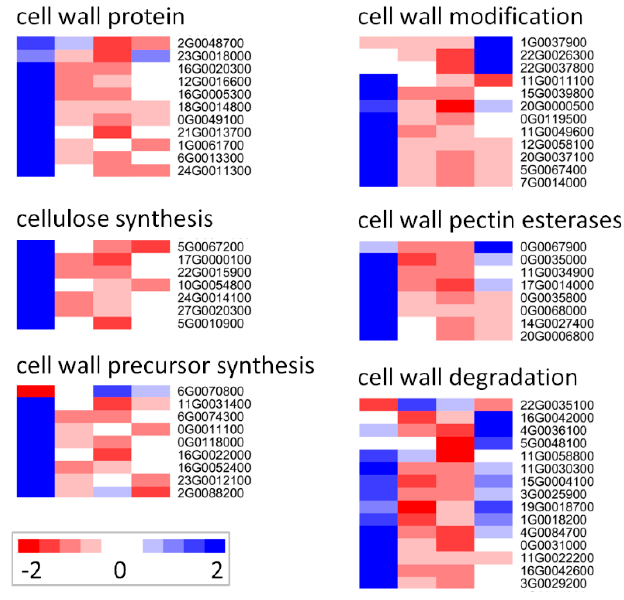
Figure 6. Expression profiles of DE genes related to cell wall. These genes are assigned into six subgroups of cell wall protein, cellulose synthesis, cell wall precursor synthesis, cell wall modification, cell wall pectin esterase, and cell wall degradation based on MapMan annotation. The FPKM values are transformed by 2-based logarithm and then normalized by row as scaled by the color bar. Each row indicates a single gene, and the cells (from left to right) represent the samples from 0, 6, 12, and 24 h after salt treatment, respectively.